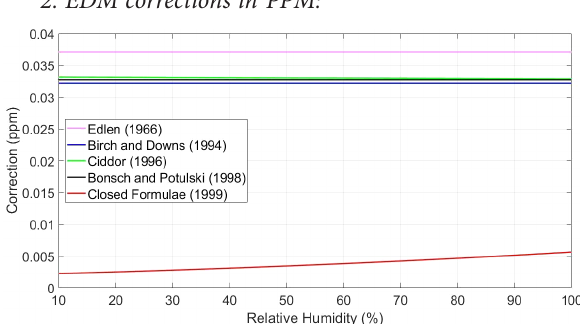
Figure 15. EDM corrections in every interval of 10%